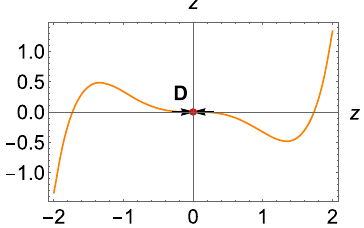
Fig. 9 One dimensional flow for (B.67) for z ∈ [− 2 , 2 ] . The origin is stable